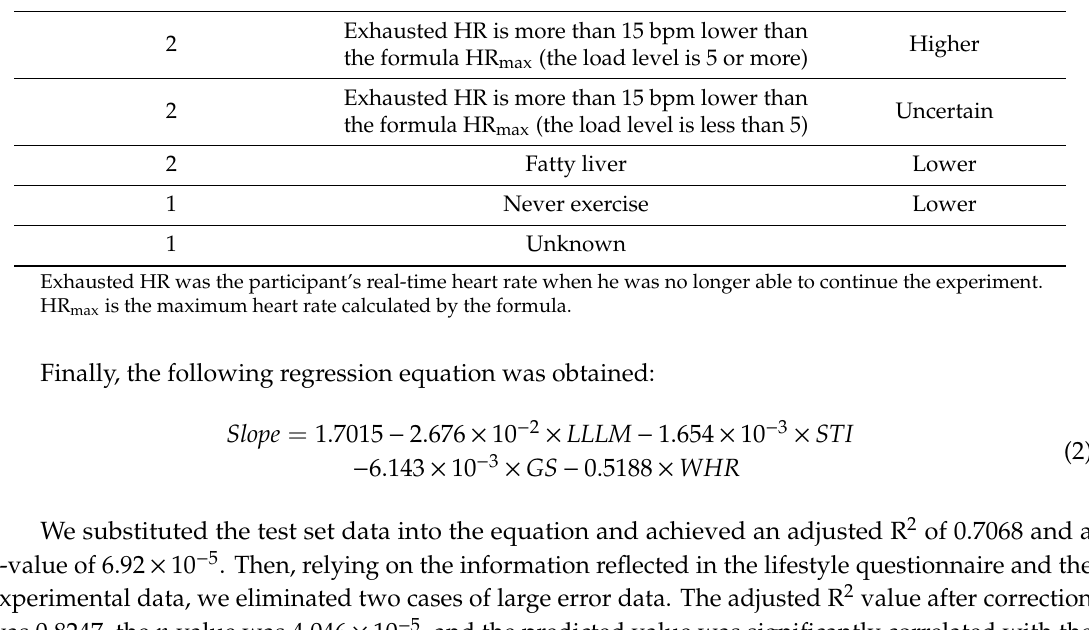
Table 3. Features of the samples with high prediction errors mined from existing questionnaires and exercise data. Number of Individuals Feature